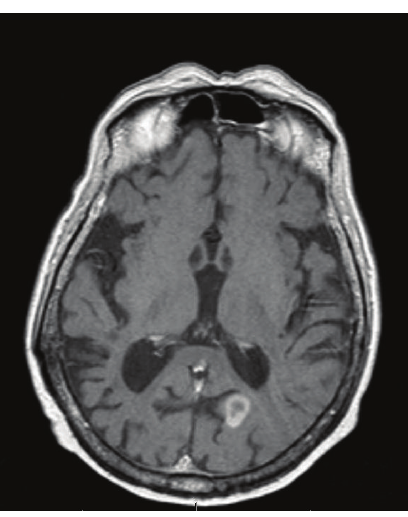
Figure 3: Magnetic resonance imaging of the brain showing ring enhancinglesionintheleftcerebellumwithmasseffectonthefourth ventricle, on initial presentation.